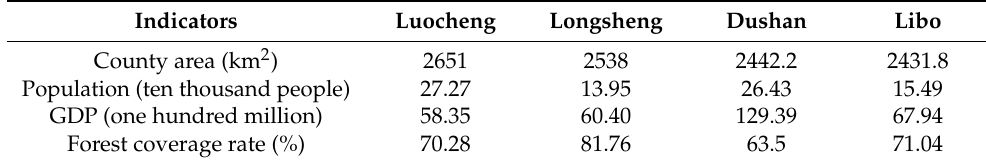
Table 1. Basic information of the four counties